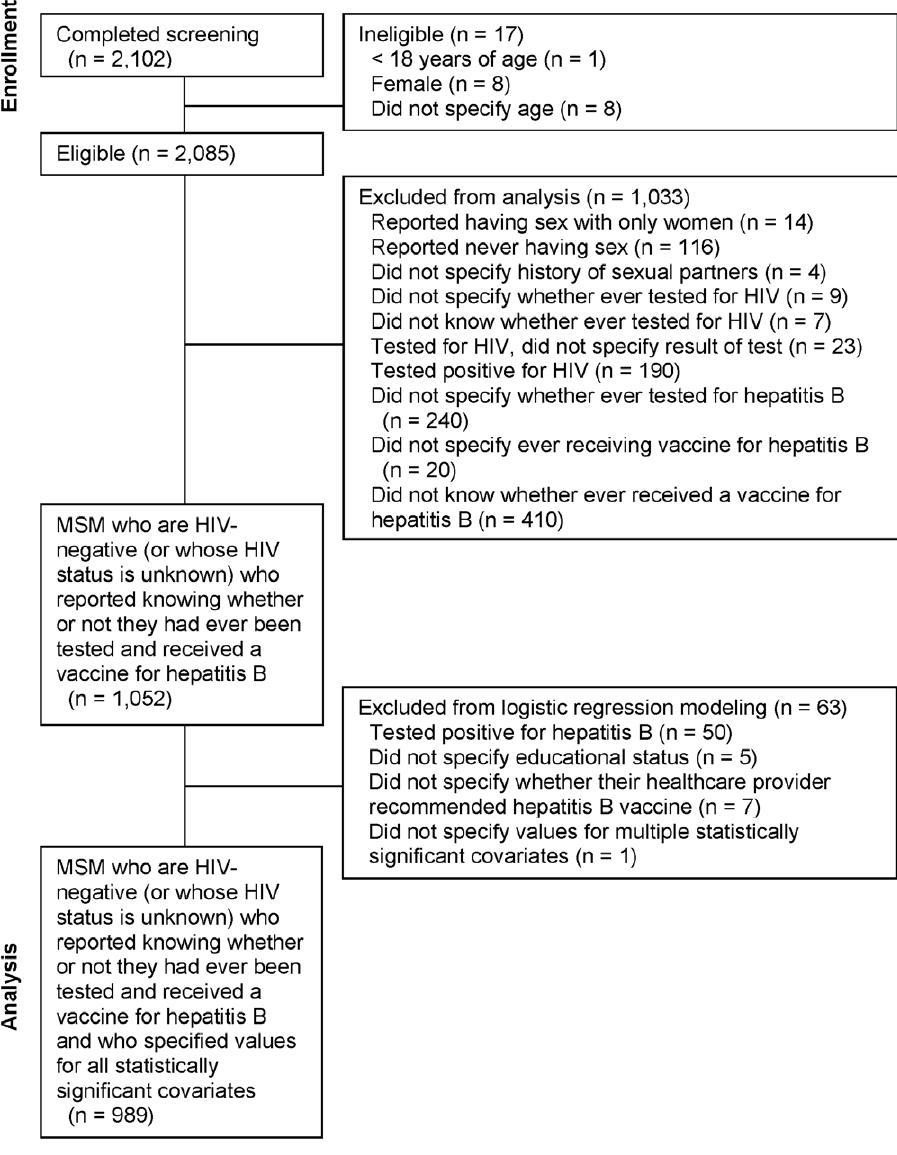
Figure 1. Derivation of study population from online cohort of MSM, United States, October–December 2010.